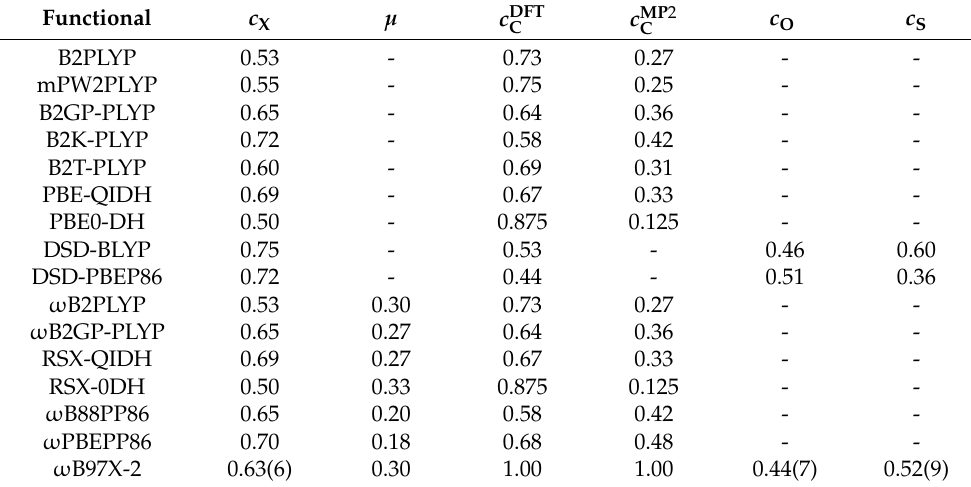
Table 2. Parameters of DHDFs according to Equations (2)–(4).